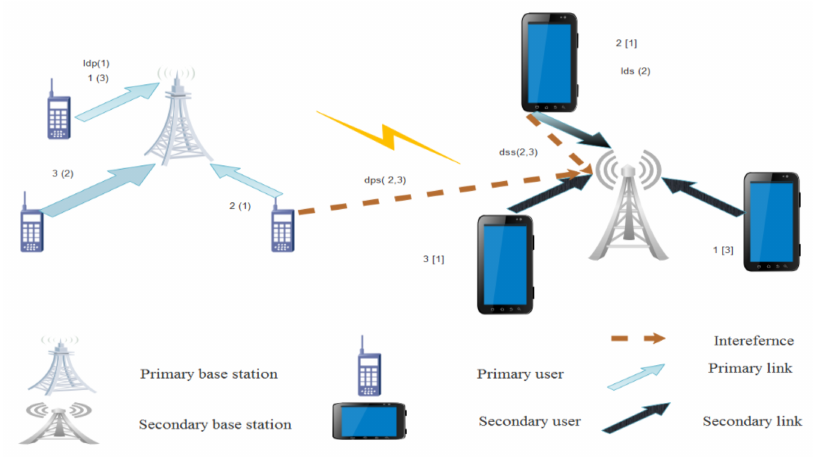
Figure 1. System